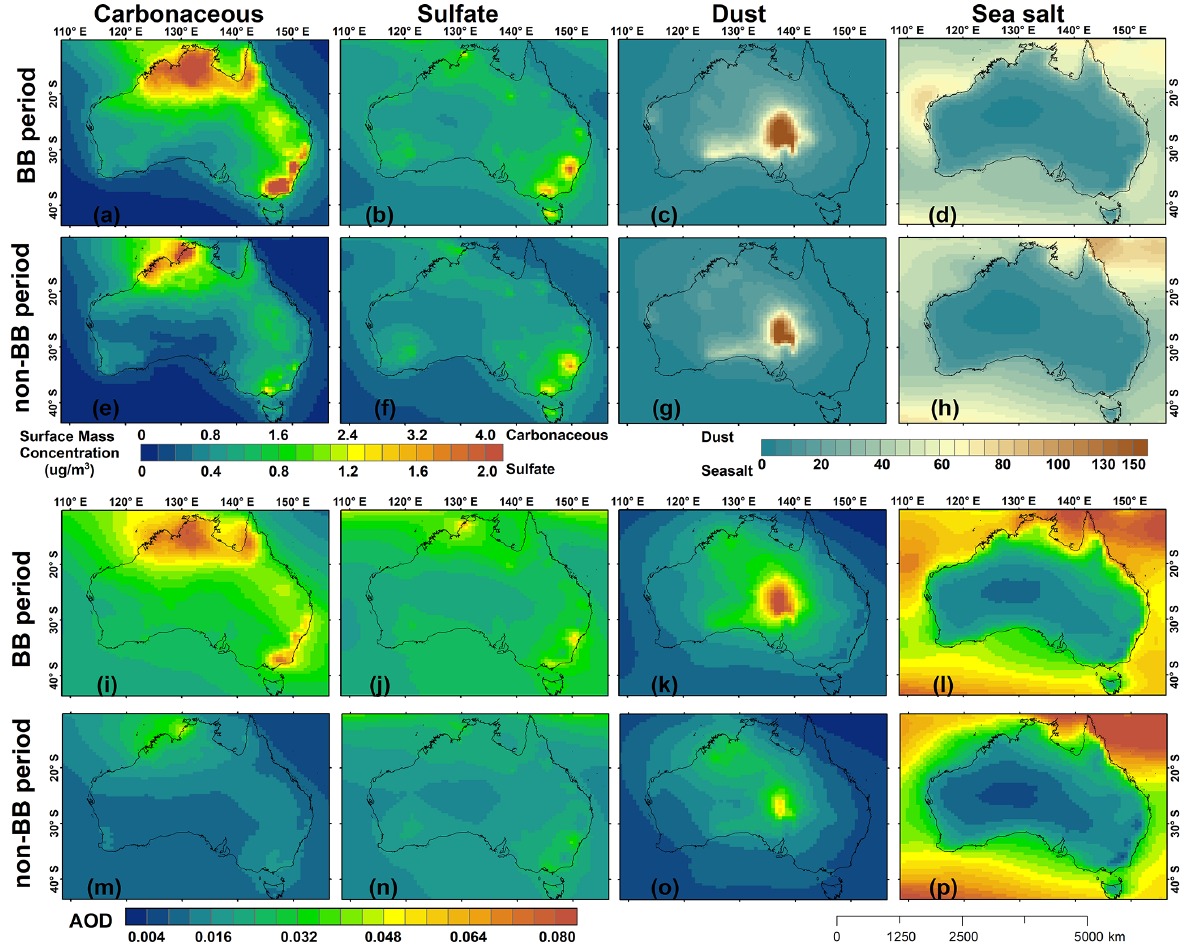
Figure 9. Spatial distribution of carbonaceous, dust, sulfate, and sea salt mass concentrations near the surface (a–h) and AOD (i–p) estimated by MERRA-2 during the BB period and the non-BB period over